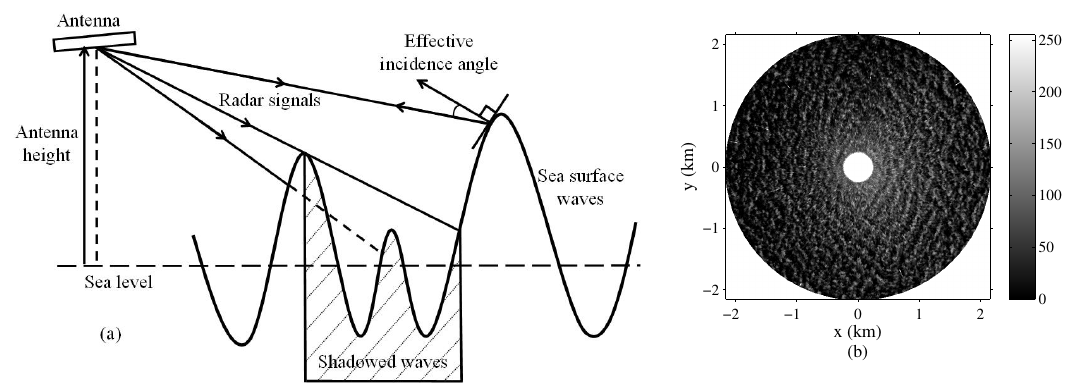
Figure 1. ( a ) Shadowing and tilt modulation; ( b ) Radar